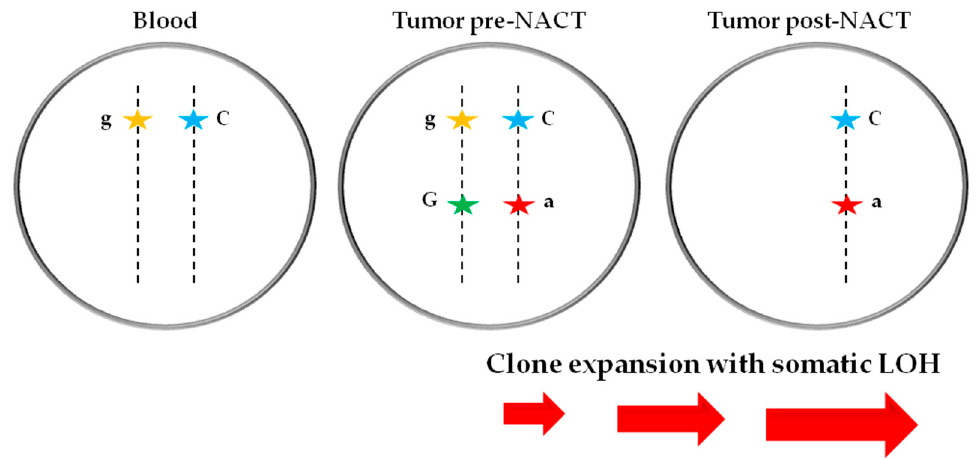
Figure 4. Representative model of double TP53 SNVs in trans configuration identified in the pre-NACT/chemo-naïve HGSOC sample at D-LPS, with clone expansion and somatic LOH in the post-NACT tumor sample collected at IDS. In normal cells (Blood) at the germline level, only the